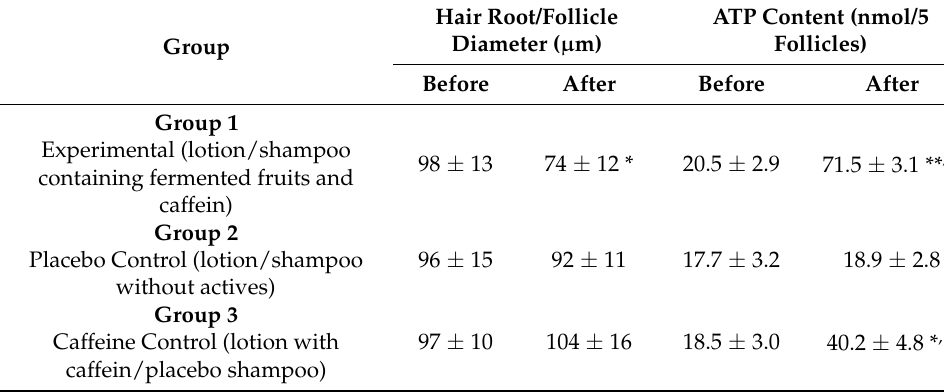
Table 4. Dynamics of hair follicle diameter and ATP content in the follicles.